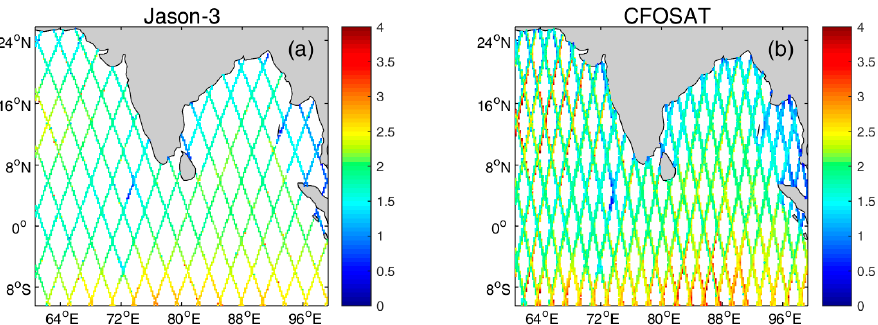
Figure 3. Significant wave height of satellite Jason-3 and CFOSAT from 1 July 2020 to 31 January 2021. Unit is meters. ( a ) SWH from satellite Jason-3; ( b ) SWH from satellite CFOSAT.